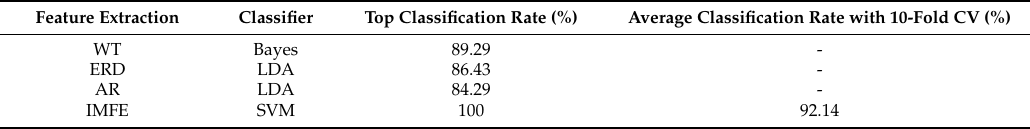
Table 3. Comparison with the top three recognition methods in BCI competition